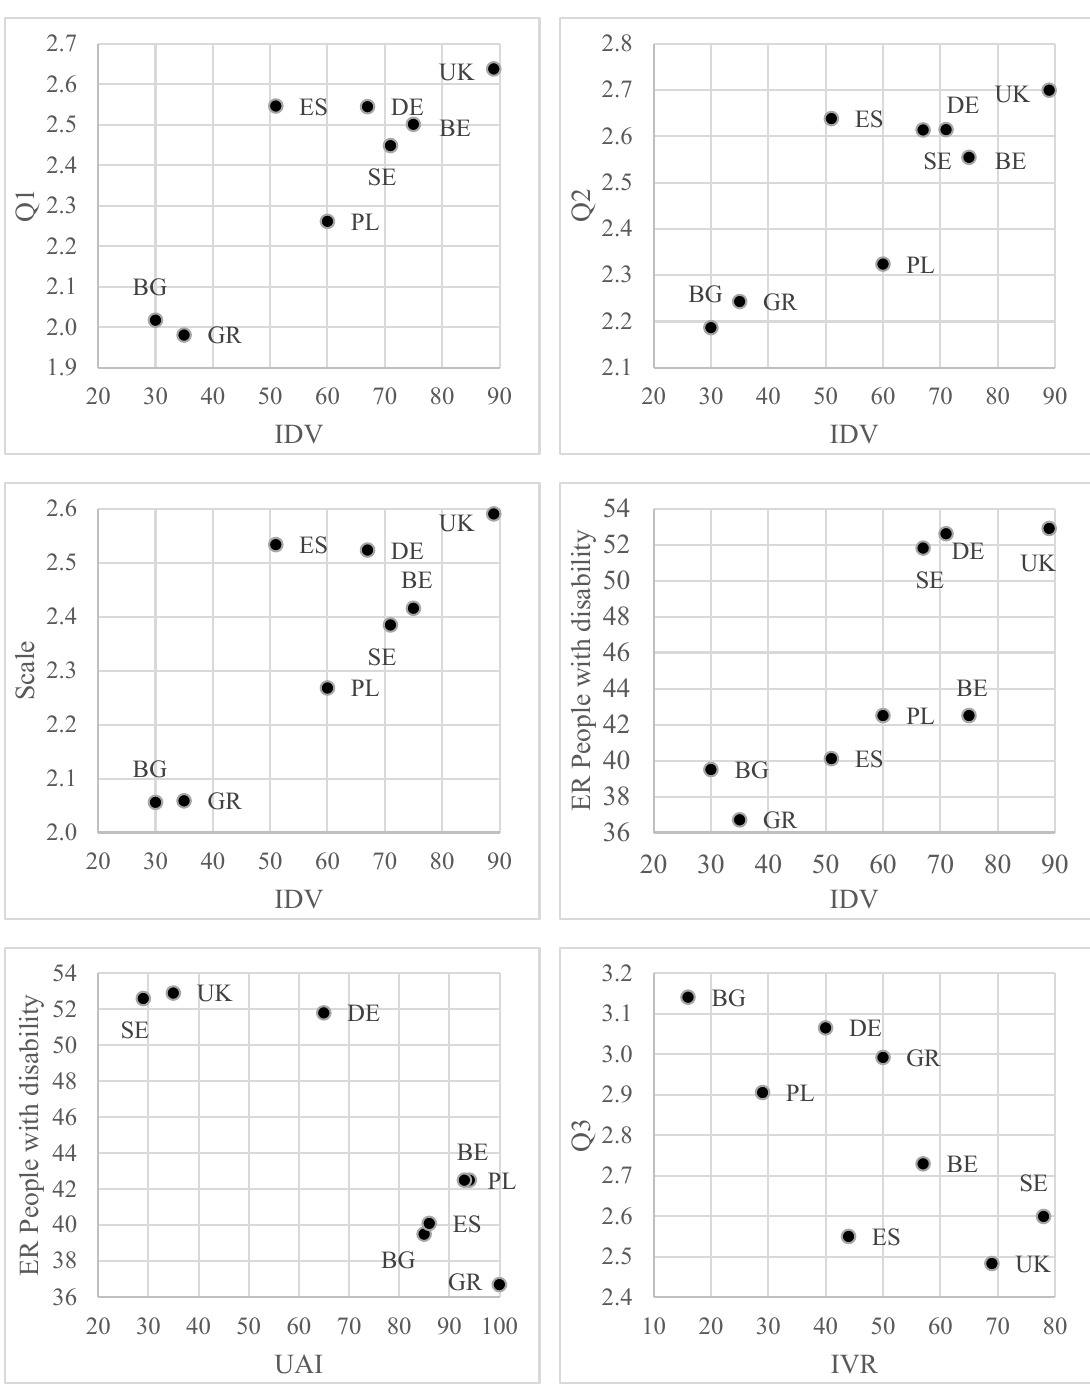
Figure 4. Graphical presentation of the results from Table 1. BG—Bulgaria, DE—Germany, UK— United Kingdom, ES—Spain, BE—Belgium, GR—Greece, PL—Poland, SE—Sweden.